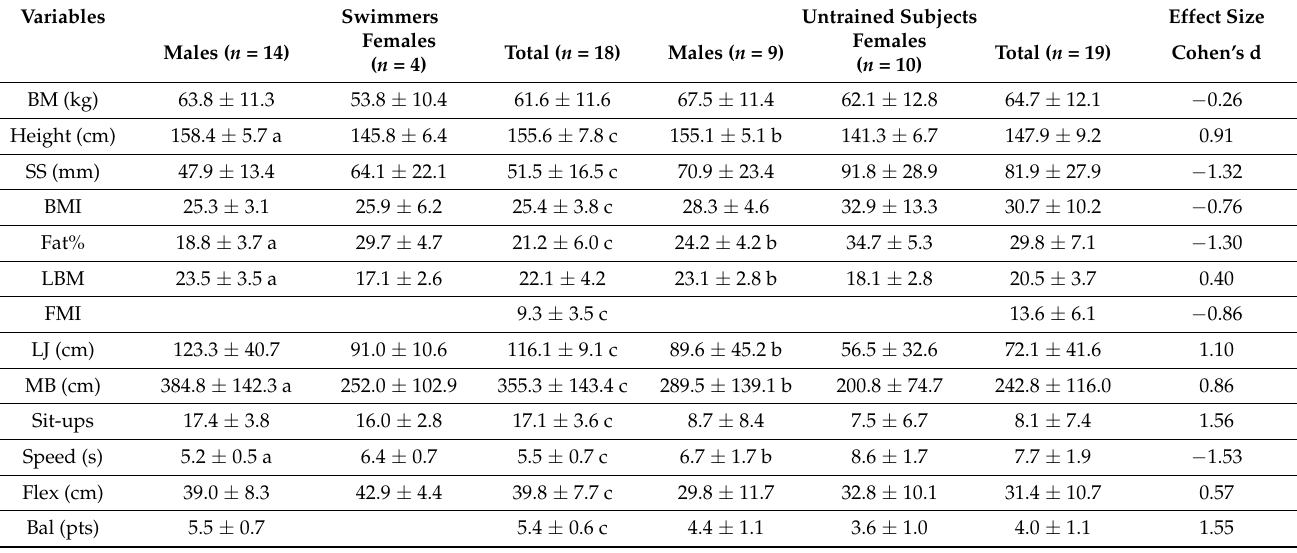
Table 1. Mean ( ± SD) and effect size values for the body composition and all variables of the Eurofit Special Test for trained swimmers and untrained subjects.